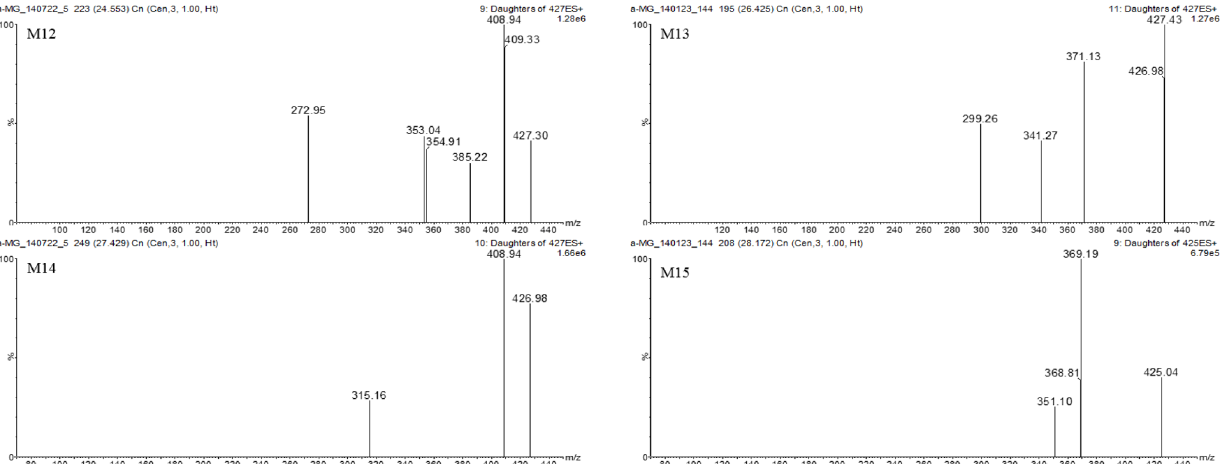
Fig 6. Spectrums of tentative metabolites (M12 – M15) detected in mice ’ s plasma, urine, feces, liver and small intestine after intravenous and oral administration of α -MG and S9 fractions of the liver and small intestine after 30 min incubation.